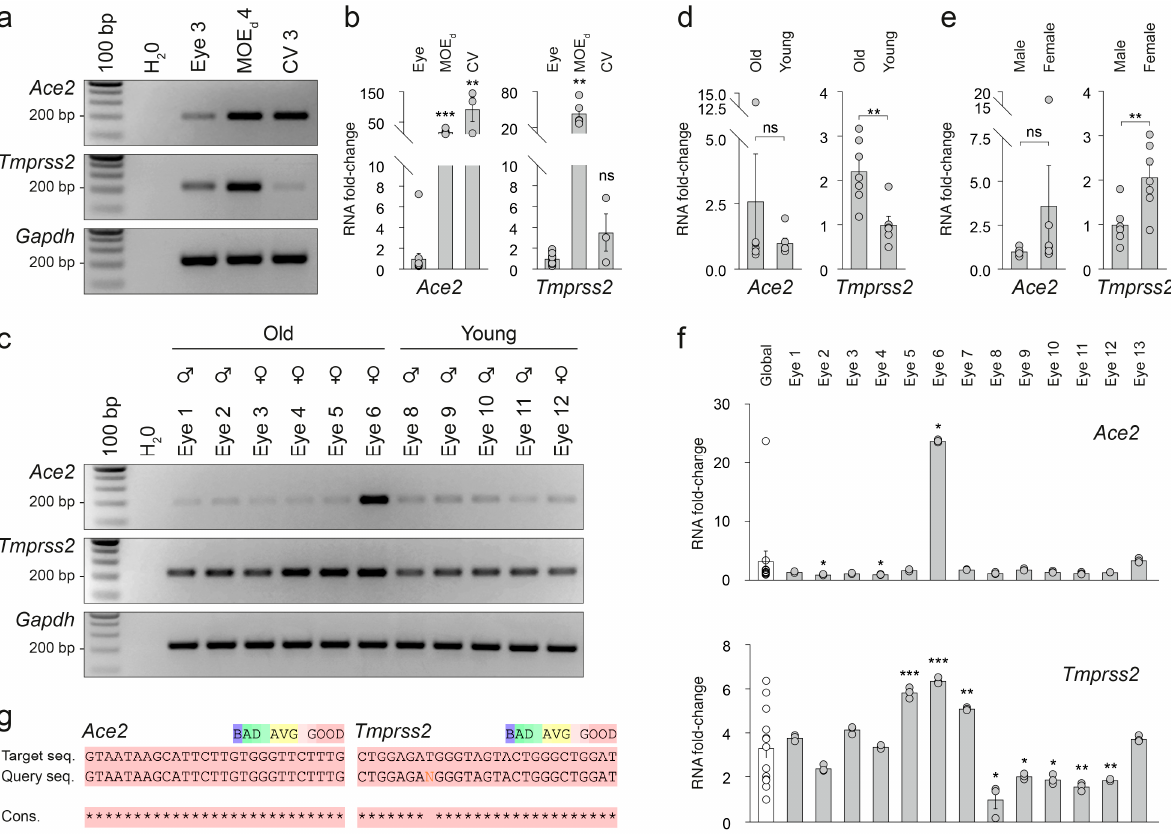
Figure 2. Ace2 / Tmprss2 gene expression profile in the mouse eye. ( a ) Representative RT-PCR results comparing Ace2 / Tmprss2 expression between the mouse sensory systems (visual, olfactory and taste systems). For the MOE d 4 sample, GFP-expressing MOE d from Gfp +/ − and +/+ mice were used. ( b ) Quantification by RT-qPCR of Ace2 / Tmprss2 expression between mouse sensory systems. ( c ) Representative RT-PCR result comparing Ace2 / Tmprss2 expression between male ( ♂ ), female ( ♀ ), old and young mouse eye samples obtained (from Table 1), illustrating individual and ectopic expression of SARS-CoV-2-associated binding genes. ( d – f ) Quantification by RT-qPCR of age, sex and interindividual differences between eye samples (Table 1). ( d ) Age-dependent expression of Ace2 / Tmprss2 genes in the mouse eye. ( e ) Sex-dependent expression of Ace2 / Tmprss2 genes in mouse eyes. ( f ) Conformity analysis between samples and global population (Global, in white) reveals the interindividual heterogenicity of Ace2 / Tmprss2 gene expression in the mouse eye. ( g ) Representative assessment of our fragment specificity, here with the Eye 6 sample. The obtained sample sequences (Query seq.) are aligned with their respective Ace2 or Tmprss2 target sequences (Target seq.). In case of a non-determined nucleotide, the symbol “N” is used. The level of the sequence conservation (Cons.) is indicated by asterisks and the color code scale. ( a – f ) H 2 O is used as a negative control of transcript expression and Gapdh as a reporter gene. Data are expressed as an RNA fold change and represented as mean ± SEM with aligned dot plots for n ≧ 3 samples/replicates. Comparisons between conditions and/or samples are performed with two-tailed Student’s t -tests or Mann–Whitney tests, * p < 0.05, ** p < 0.01, *** p < 0.001, ns for non-significant. Ladder of 100 base pairs (bp, ( a , c )).